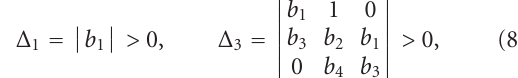
Figure 4: Rigid shaft stability behavior for conventional and hybrid for di ff erent lubricant pressure supplies and (b) designs: (a) p 2 RS,thr equilibrium locus for S = 0 . 1416, 0 . 2833 where eccentricities and attitude angles for four injection pressures are